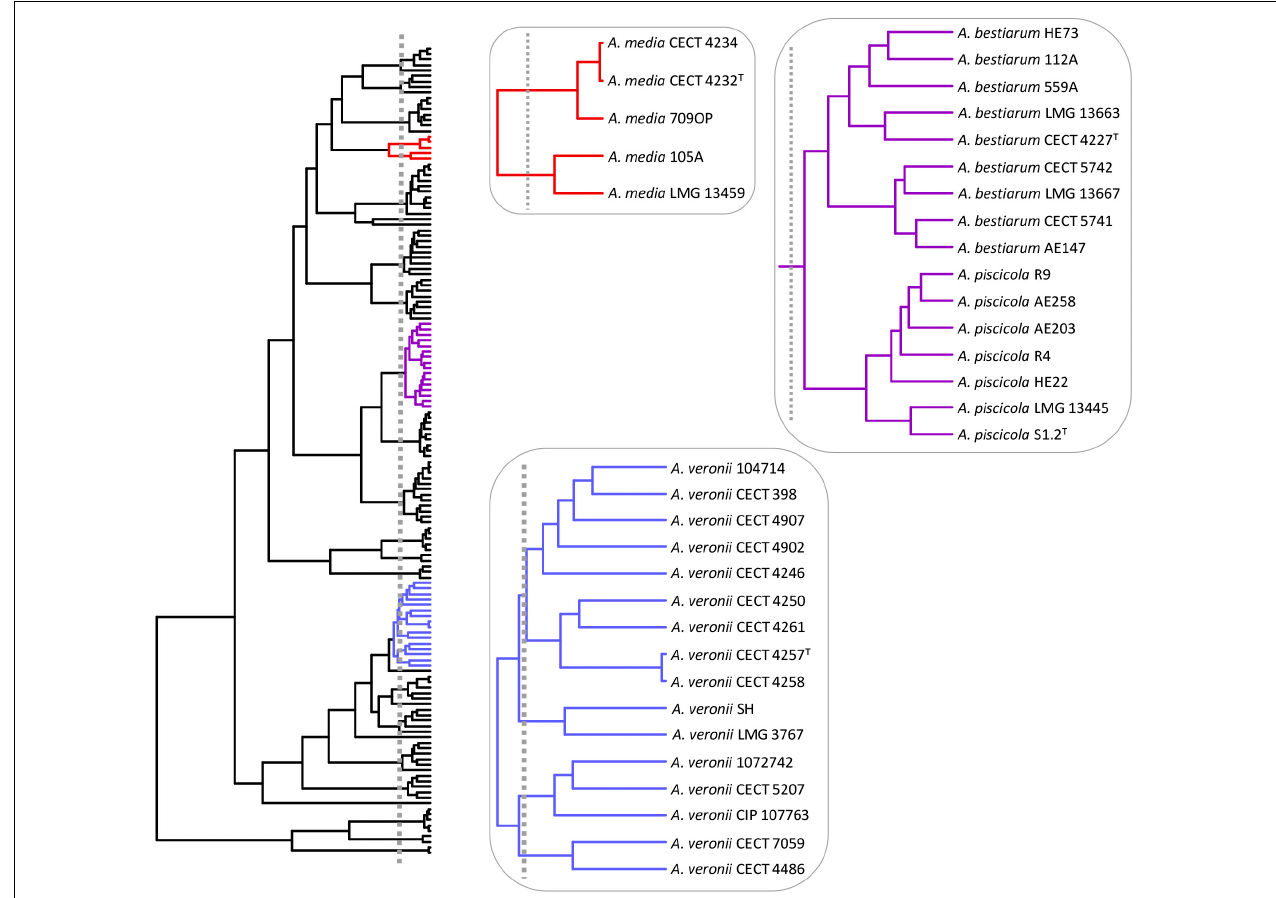
FIGURE 8 | Aeromonas species delimitation. Phylogenetic tree obtained with the GMYC method. In boxes are the species clusters that present taxonomic uncertainties when using the estimated breakpoint to delimit